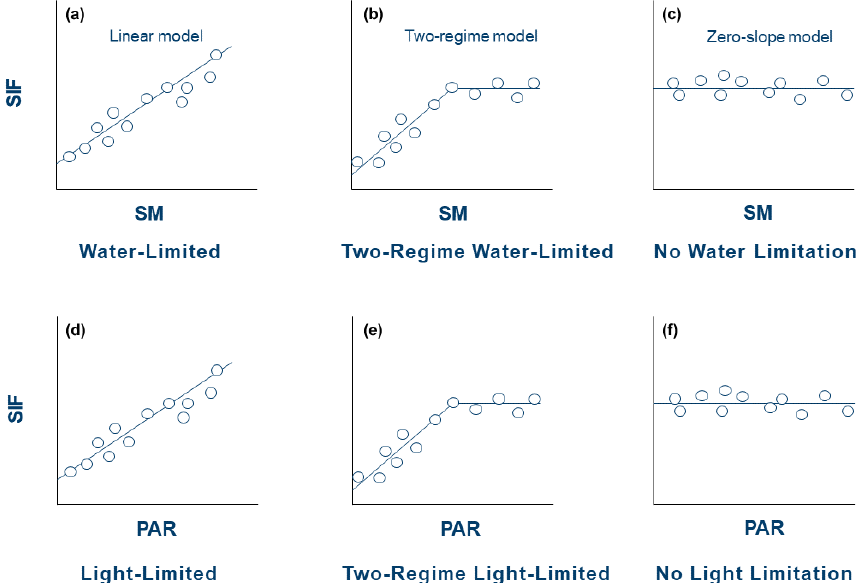
Figure 4. Schematics of model types for the SIF–SM and SIF–PAR regimes. The Bayesian information criterion (BIC) is used to avoid overfitting among models during statistical